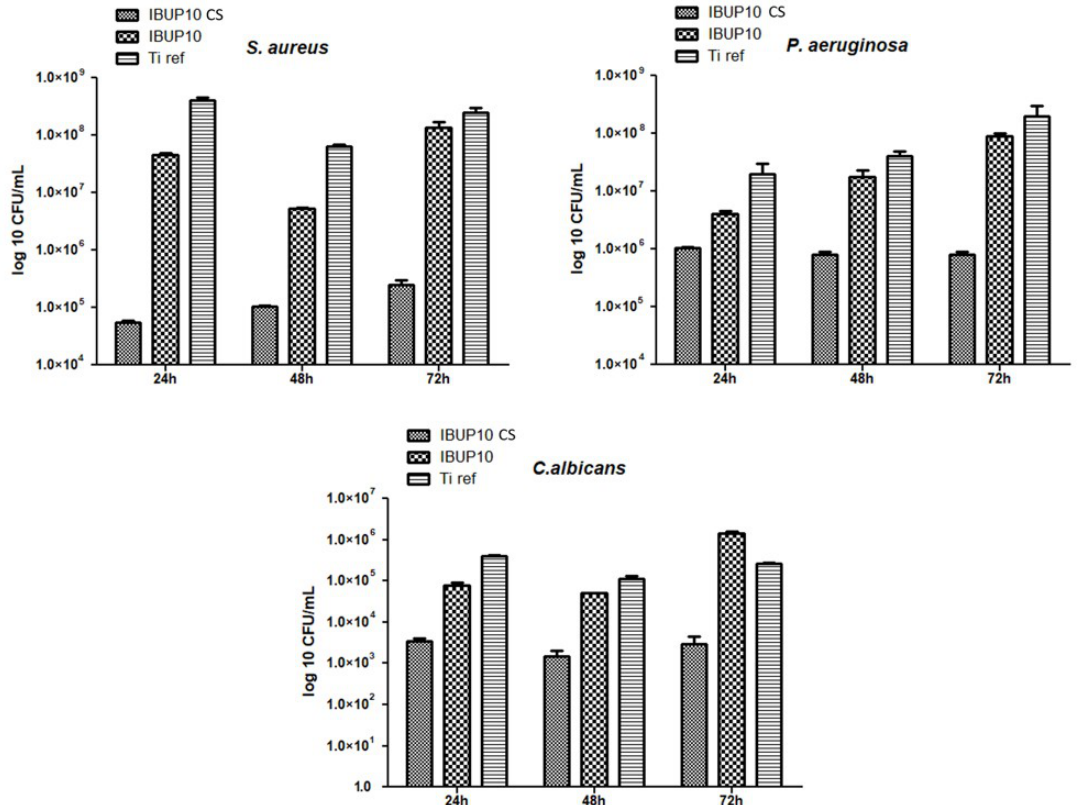
Figure 11. Dynamic biofilm formation ability of tested microbial species in the presence of composite biopolymeric spheres coatings.